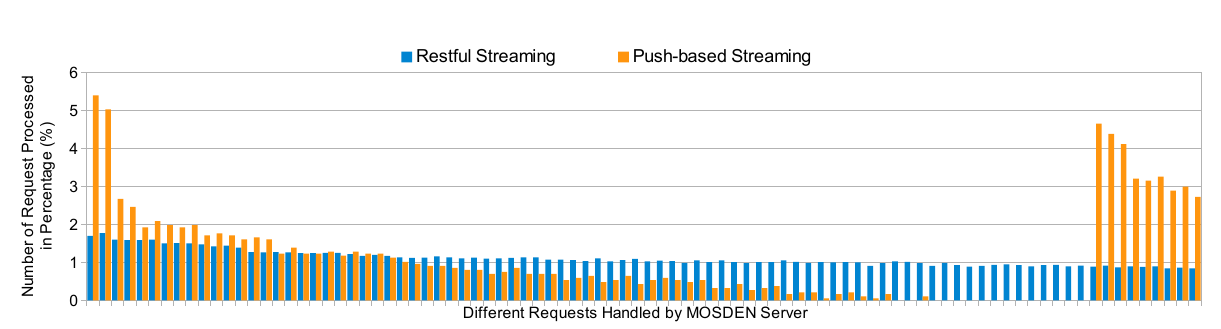
Figure 17. Comparison of Requests Processing Variation